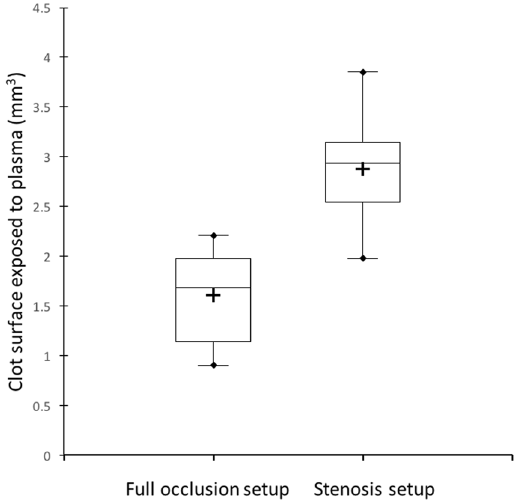
Figure 6. Surface contact between the blood clot and the plasma in the stenosis and full occlusion